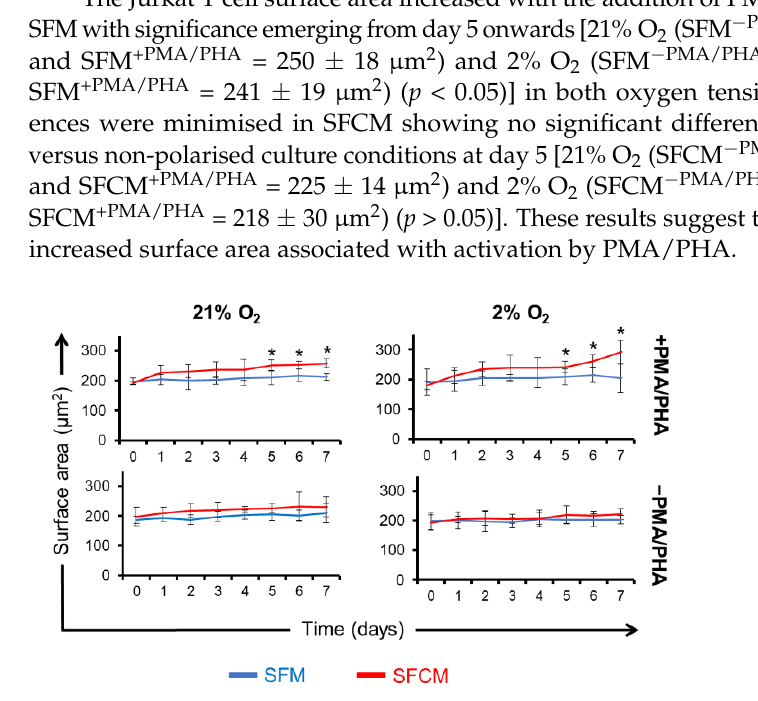
Figure 2. SFCM protects Jurkat T cells from PMA/PHA-induced morphological changes. Cell surface area measurements ( µ m 2 ) of Jurkat T cells ± PMA/PHA cultured in SFM versus SFCM in both air (21% O 2 ) and physoxia (2% O 2 ) over 7 days. Jurkat T cell timepoint samples were cytospinned, fixed, and stained with Giemsa – May – Grunwald’s stain. Data expressed as mean ± SD of 3 spots for each slide ( n = 3), * p < 0.05.